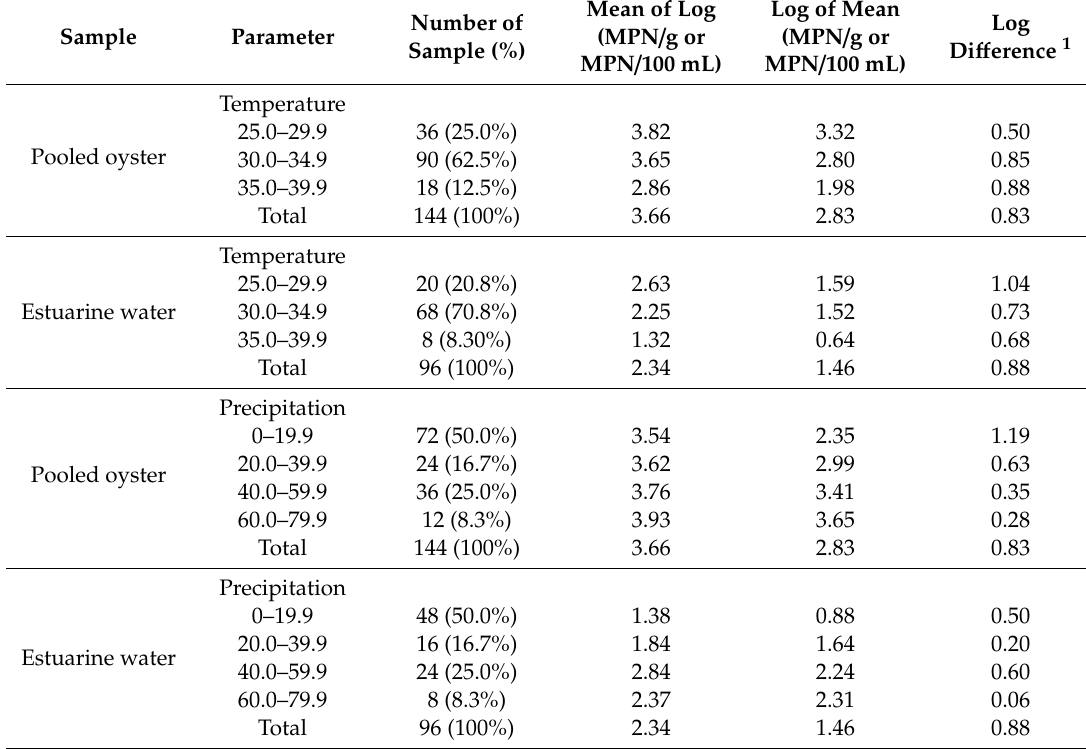
Table 5. Summary of average concentrations of E. coli / g of oyster meat and E. coli / 100 mL of